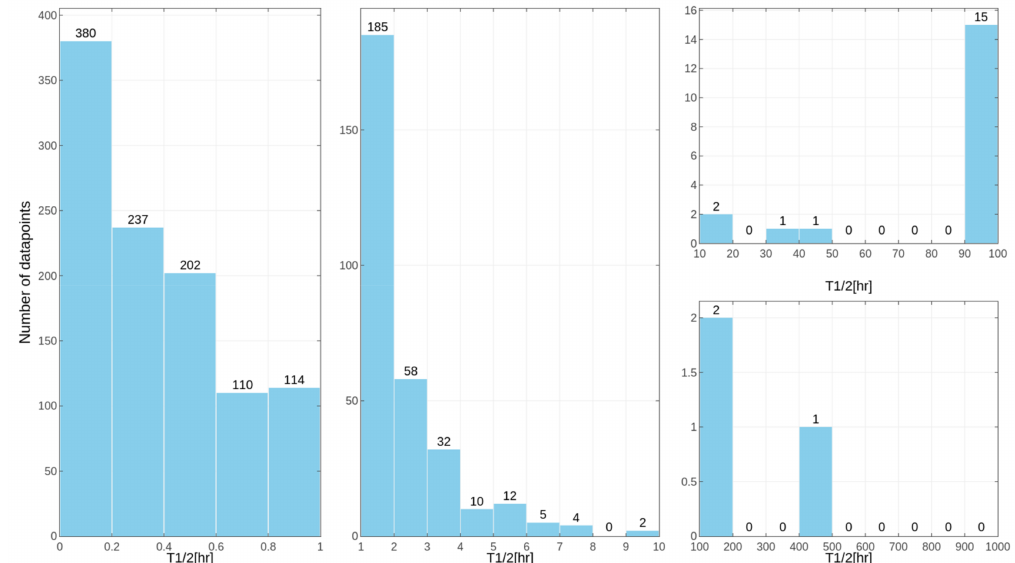
Figure 2. Distribution of compound half-lifetimes in the constructed datasets referring to experiments performed on rat samples. For better visualization, the dataset was divided into several parts.